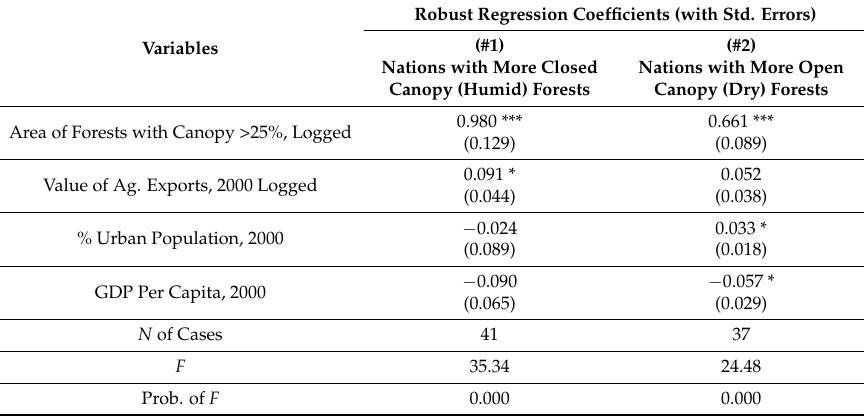
Table 3. Forest Losses (logged), 2000–2012, across Wet and Dry Forested